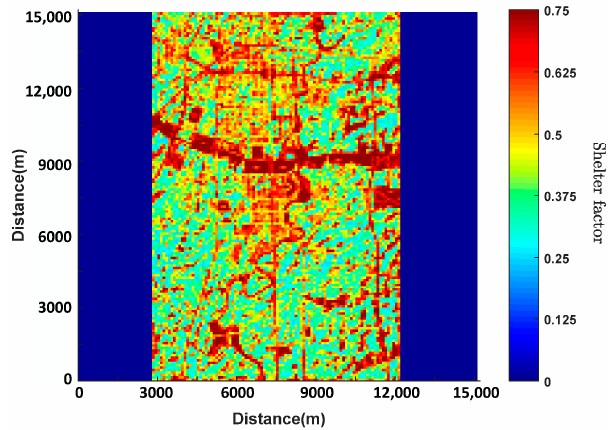
Figure 7. Shelter factor